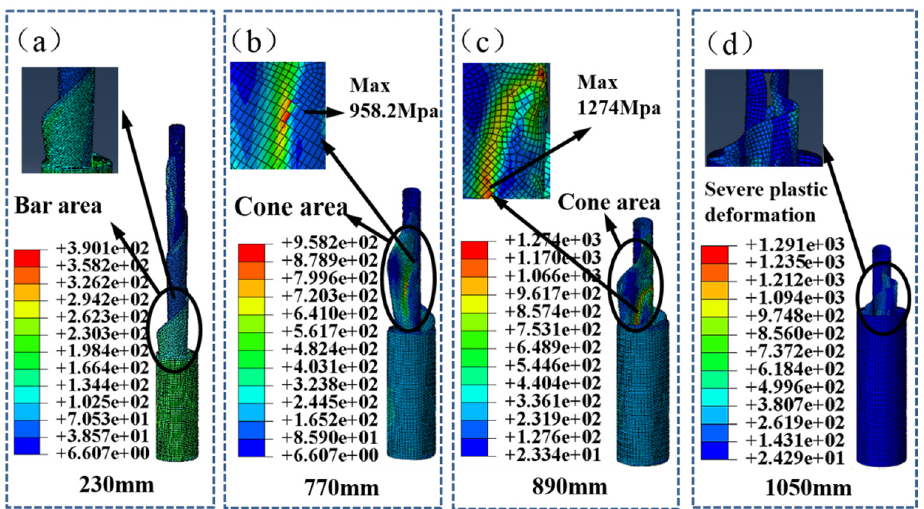
Figure 7. Gathering process with the top rod radius of 9.3 mm when the gathering length is ( a ) 230 mm; ( b ) 770 mm; ( c ) 890 mm; or ( d ) 1050 mm.